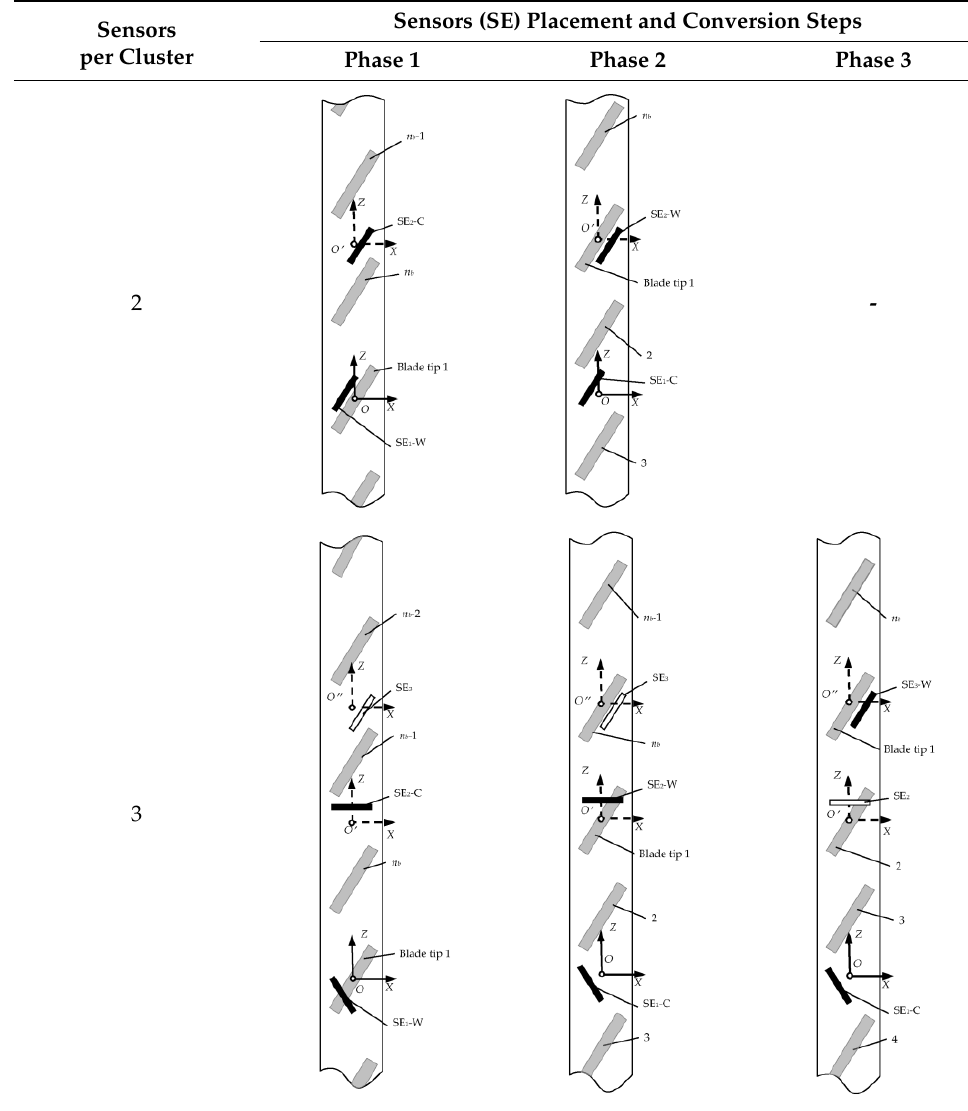
Table 2. Methods for the discrete surfaces (blade tips) monitoring on the base of distributed clusters of SCECS.